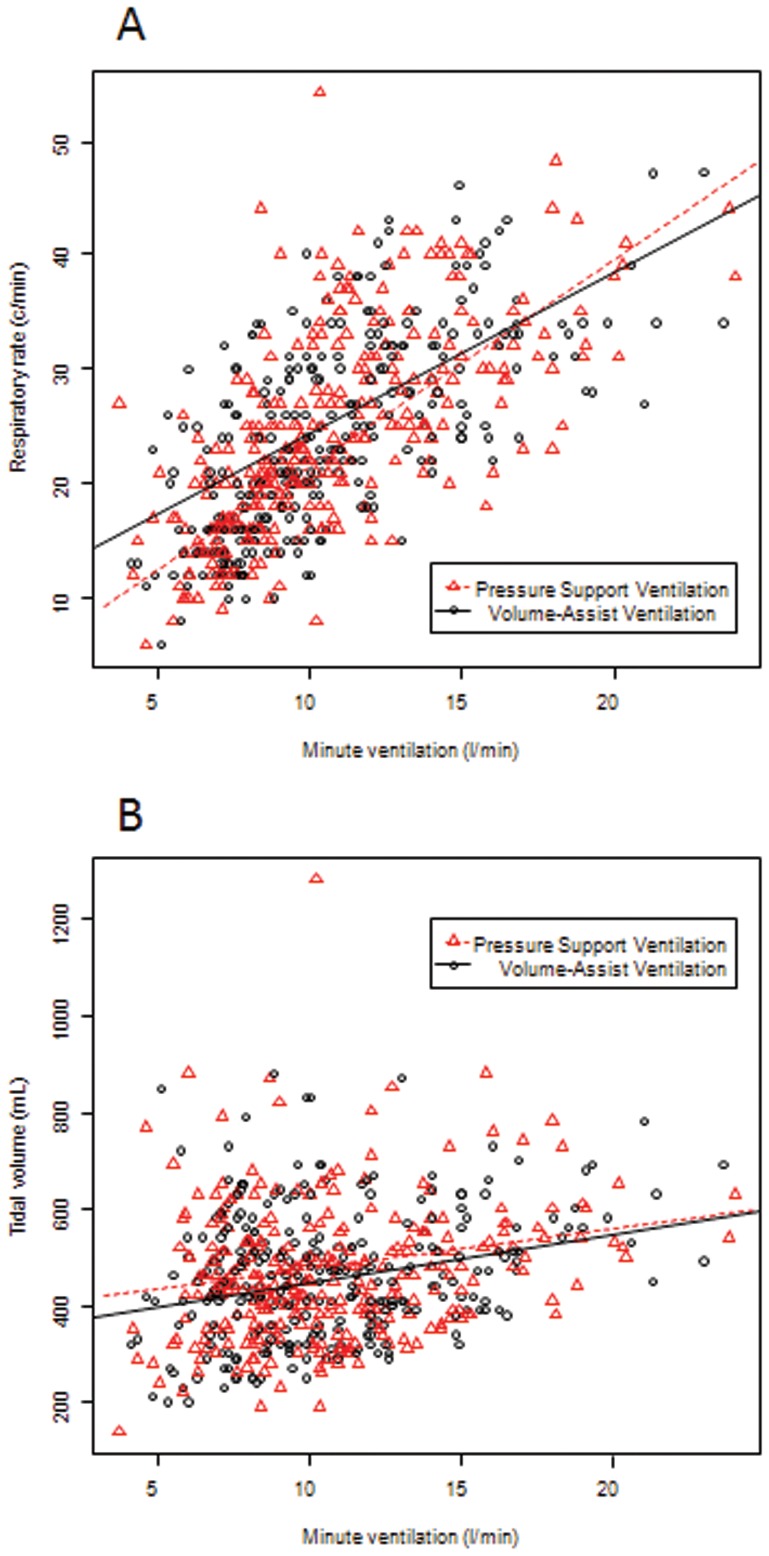
Relationship between minute ventilation and respiratory rate or tidal volume after treatment by acetazolamide.Relationship between minute ventilation and respiratory rate (A) or tidal volume (B) according to the ventilator mode in 68 COPD patients after treatment by acetazolamide (acetazolamide, 250 to 500 mg twice daily) during the weaning from mechanical ventilation period. The increase in minute ventilation after administration of acetazolamide was a consequence of the increase of respiratory rate rather than the increase of tidal volume, whatever the ventilator mode. Every point is one observation after acetazolamide administration (see text for details). Regression lines for both pressure-support (dotted line) and volume-assist (solid line) ventilation are represented on the figure.